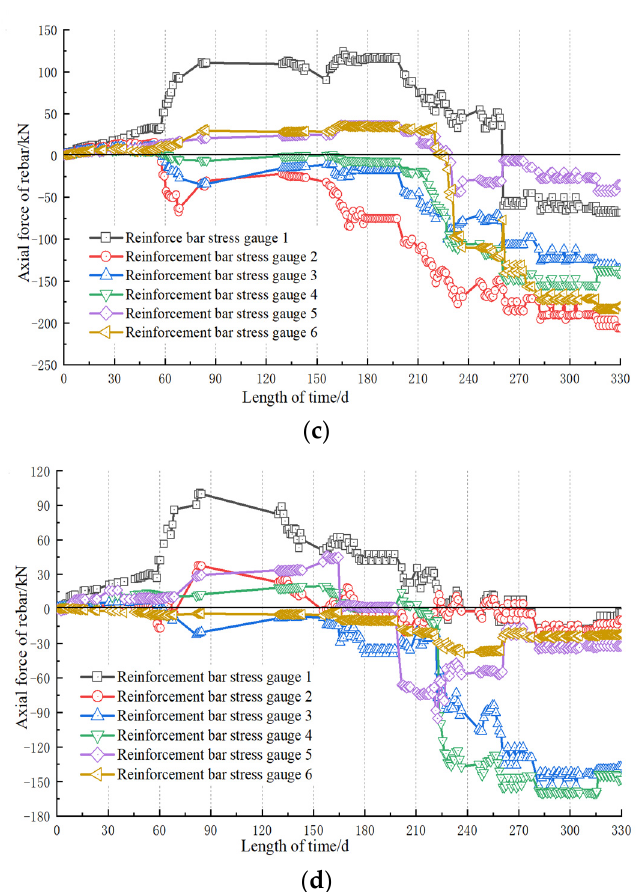
Figure 19. Reinforcement axial force curve of retaining piles. ( a ) E2; ( b ) W1; ( c ) W3; ( d ) W4. Figures 20 and 21 show the stress change curve of crown beams and the strain change curve of waist beams, respectively. To clearly present the change characteristics of the whole support beam, only some points of the deformation curve are mapped.